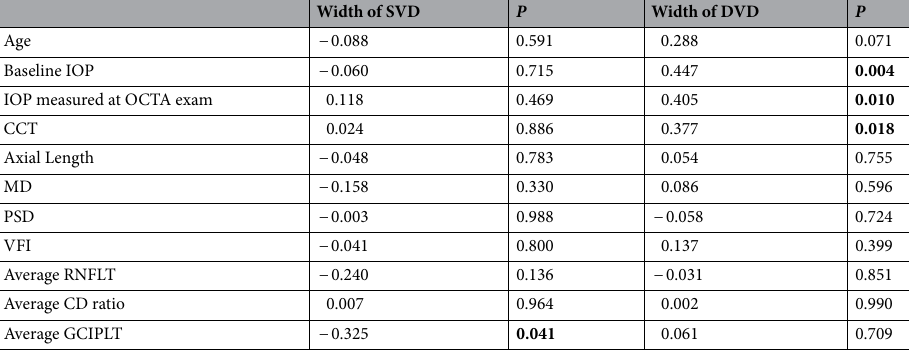
Table 3. Correlation coefficients between the width of vessel defect in each layer and structural or functional parameters in eyes with MD < − 3 dB. SVD superficial vessel defect, DVD deep vessel defect, IOP intraocular pressure, OCTA optical coherence tomography angiography, CCT central corneal thickness, MD mean deviation, PSD pattern standard deviation, VFI visual function index, RNFLT retinal nerve fiber layer thickness, CD cup to disc, GCIPLT ganglion cell inner plexiform layer thickness. Bold font indicates significant P values ( P < 0.05). Pearson correlation analysis was used.